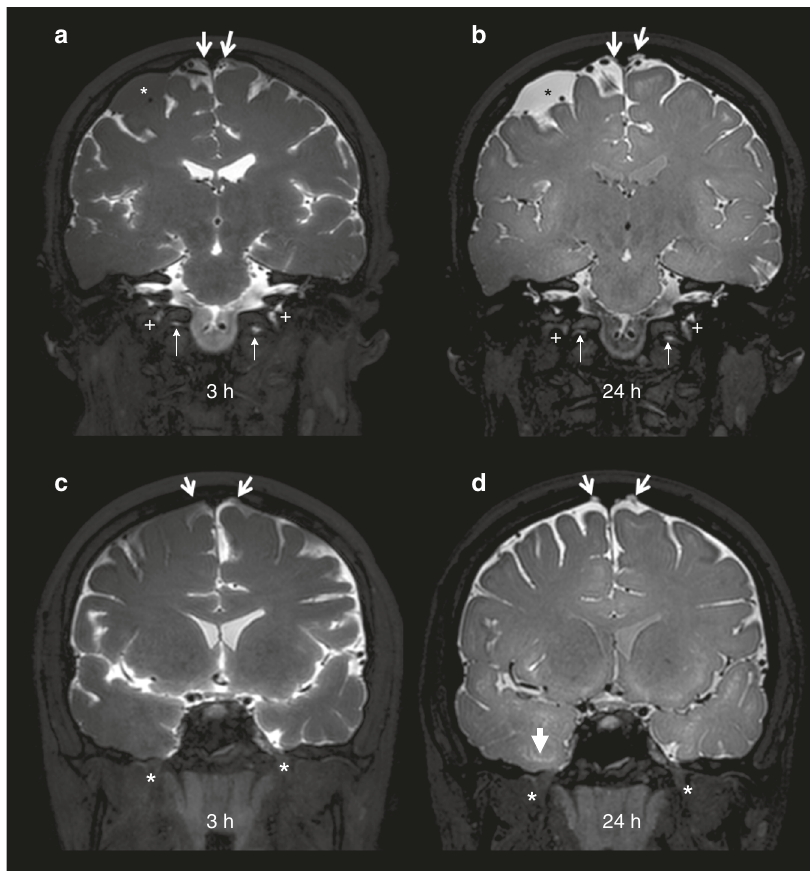
Fig. 5 Evidence for CSF ef fl ux along cranial nerves. Posterior ( a , b ) and anterior ( c , d ) mid-coronal T1-BB from a patient (no. 10) under work-up for symptoms possibly related to an arachnoid cyst (asterisks in a and b , respectively) at the upper convexity of the right cerebral hemisphere. As compared to 3 h after intrathecal gadobutrol ( a ), the cyst enhanced homogenously at scans after 24h ( b ). Enrichment of parasagittal dura (thick arrows) increased from 3 ( a , c ) to 24h ( b , d ), respectively. CSF tracer within brain perivascular spaces is well illustrated with T1-BB MRI (exempli fi ed as pointed out by arrowheads; d ). In addition is shown CSF tracer enhancement below the skull base outlets of the jugular foramen (crosses) and hypoglossal canal (thin arrows) ( a , b ). In the same patient, there was no sign of tracer enhancement along the mandibular nerve below level of the oval foramen (asterisks) at any time point ( c , d ).